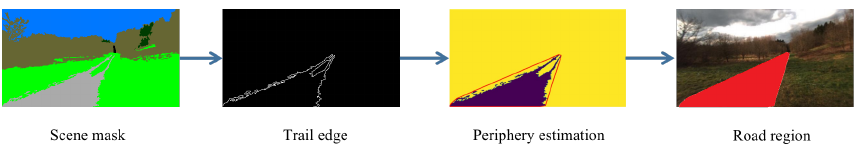
Figure 4. Road detection process using scene mask and edge information. The second image refers to the the edge of the trail and enclosed red line in the third image refers to the periphery of image. The red part in the last image is the road region in